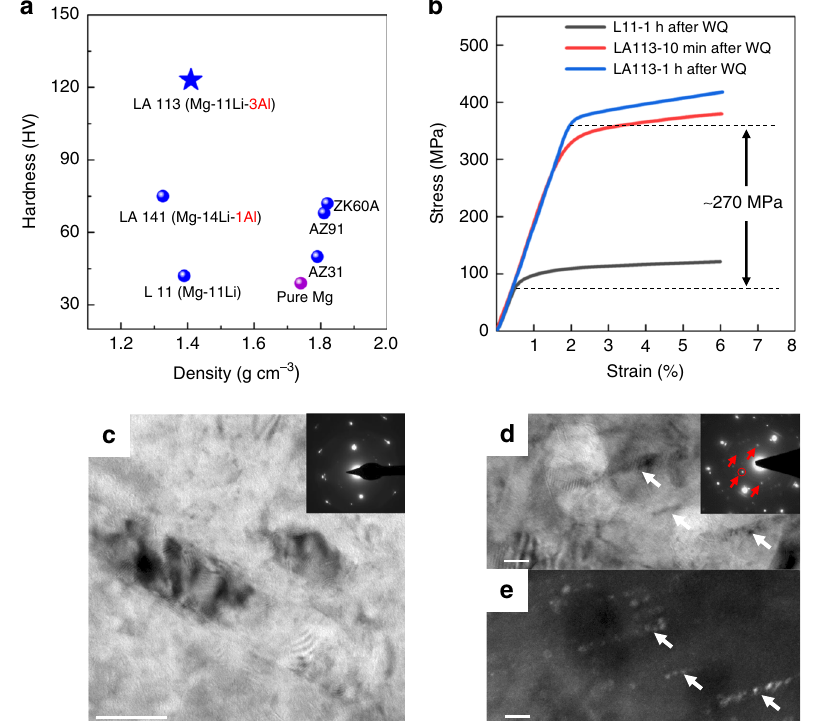
Fig. 1 Mechanical properties and typical transmission electron microscope (TEM) images of L11 and LA113. a Vickers hardness as a function of density of selected water-quenched (WQ) Mg-Li-based alloys, compared with high purity Mg and some conventional commercial Mg alloys. b Ambient temperature stress – strain curves of L11 and LA113 tested in uniaxial compression after solution treatment at 400°C and water quenching. c , d Bright- fi eld TEM images of WQ L11 and LA113, respectively. The insets show the selected area electron diffraction (SAED) patterns of the corresponding microstructure indexed as <011> β . The red arrows show the superlattice diffraction spots corresponding to a body-centred cubic (BCC)-based D0 3 ordered structure. e Dark- fi eld image taken from the re fl ection marked by the red circle in d . Typical rod-like precipitates are marked by white arrows in c , d . Scale bar, 50 nm in c and 20 nm in d ,